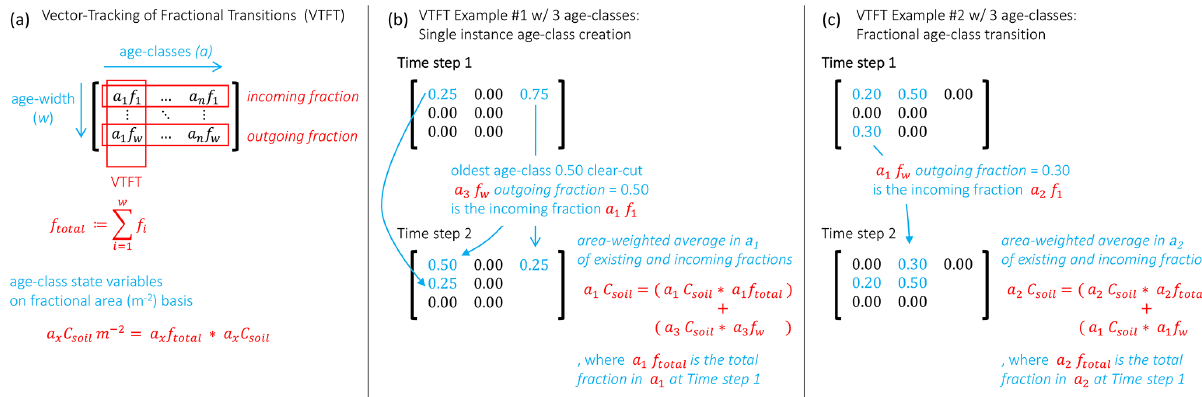
Figure 2. Methodological examples of the matrix-based method called vector-tracking of fractional transitions for computationally efficient simulation of age classes in large-scale models. (a) Hypothetical matrix of VTFT vectors of fractional areas ( f ). The total area of the age class is the sum of the fractional areas in the corresponding VTFT vector. State variables are calculated on an area basis by accounting for the fractional area of the age class; in this example, C soil is the carbon in soil. (b) An example of the VTFT method for a newly created age class by clear-cut wood harvest. An area-weighted average updates age-class state variables in the youngest age class using the preceding total fractional area of the age class and the incoming fraction. (c) A VTFT example for a fractional age-class transition. An area-weighted average updates state variables in an age class using the preceding total fractional area of the age class and the incoming fraction from the younger age